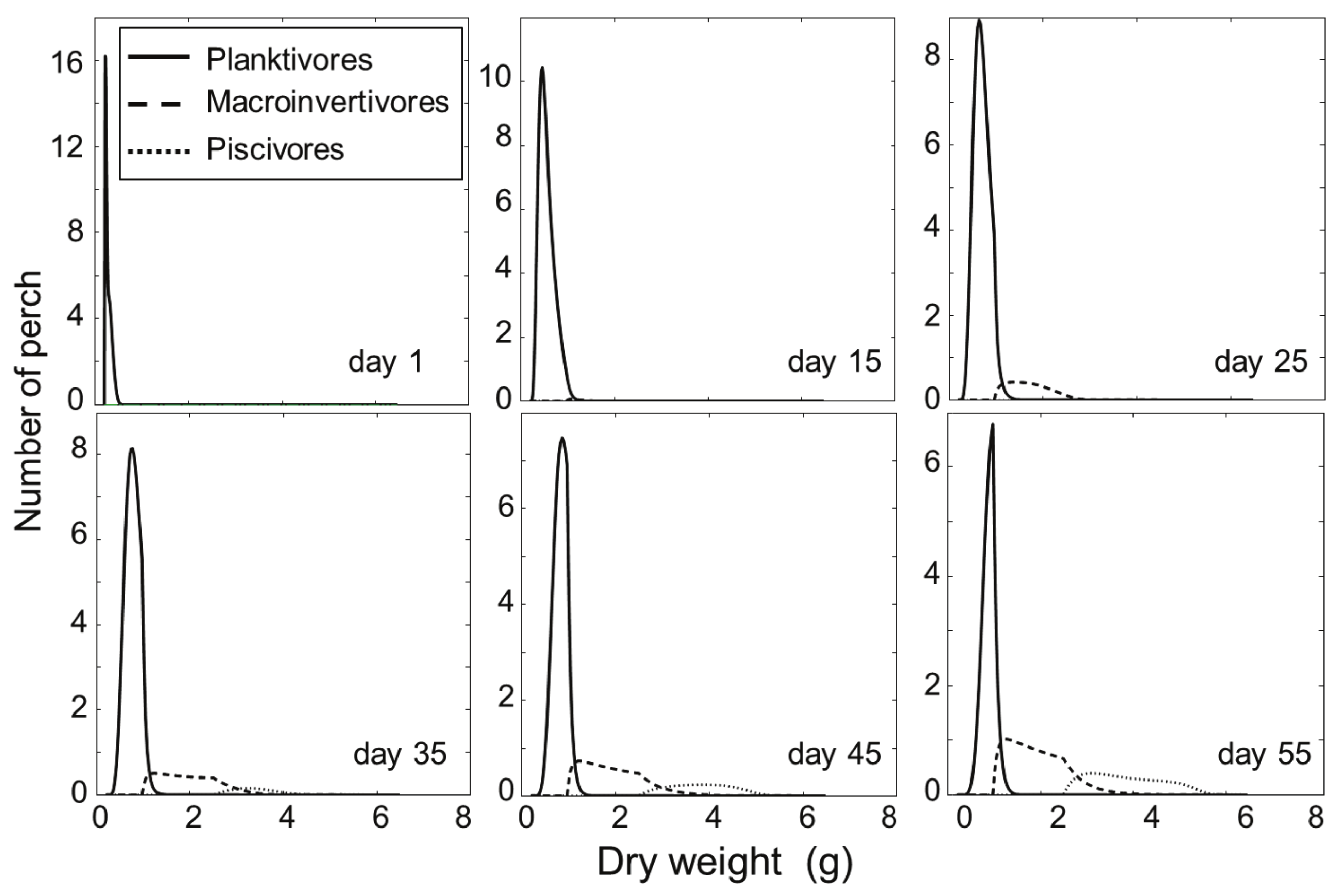
Fig 4. Weight distribution (g dry weight) of young-of-the-year perch simulated in the stage-structured model. Model output is shown for day 1, 15,25,35,45and 55 of the growth season. Only the small size-cohortwas modelled,where perch can be planktivorous, macroinvertivorous or piscivorous.